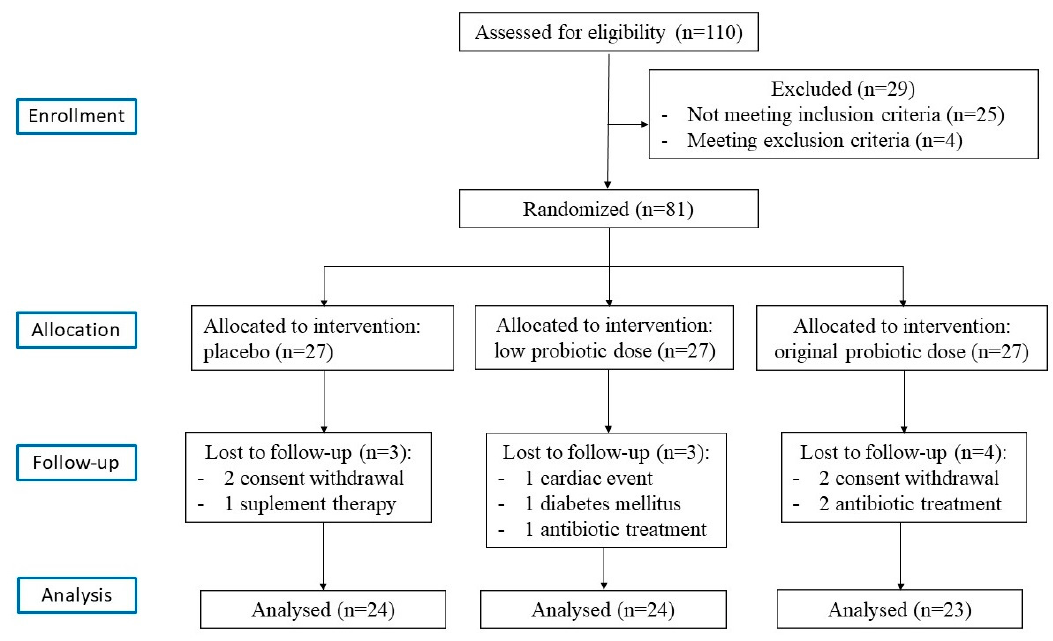
Figure 1. A flowchart of the study design.